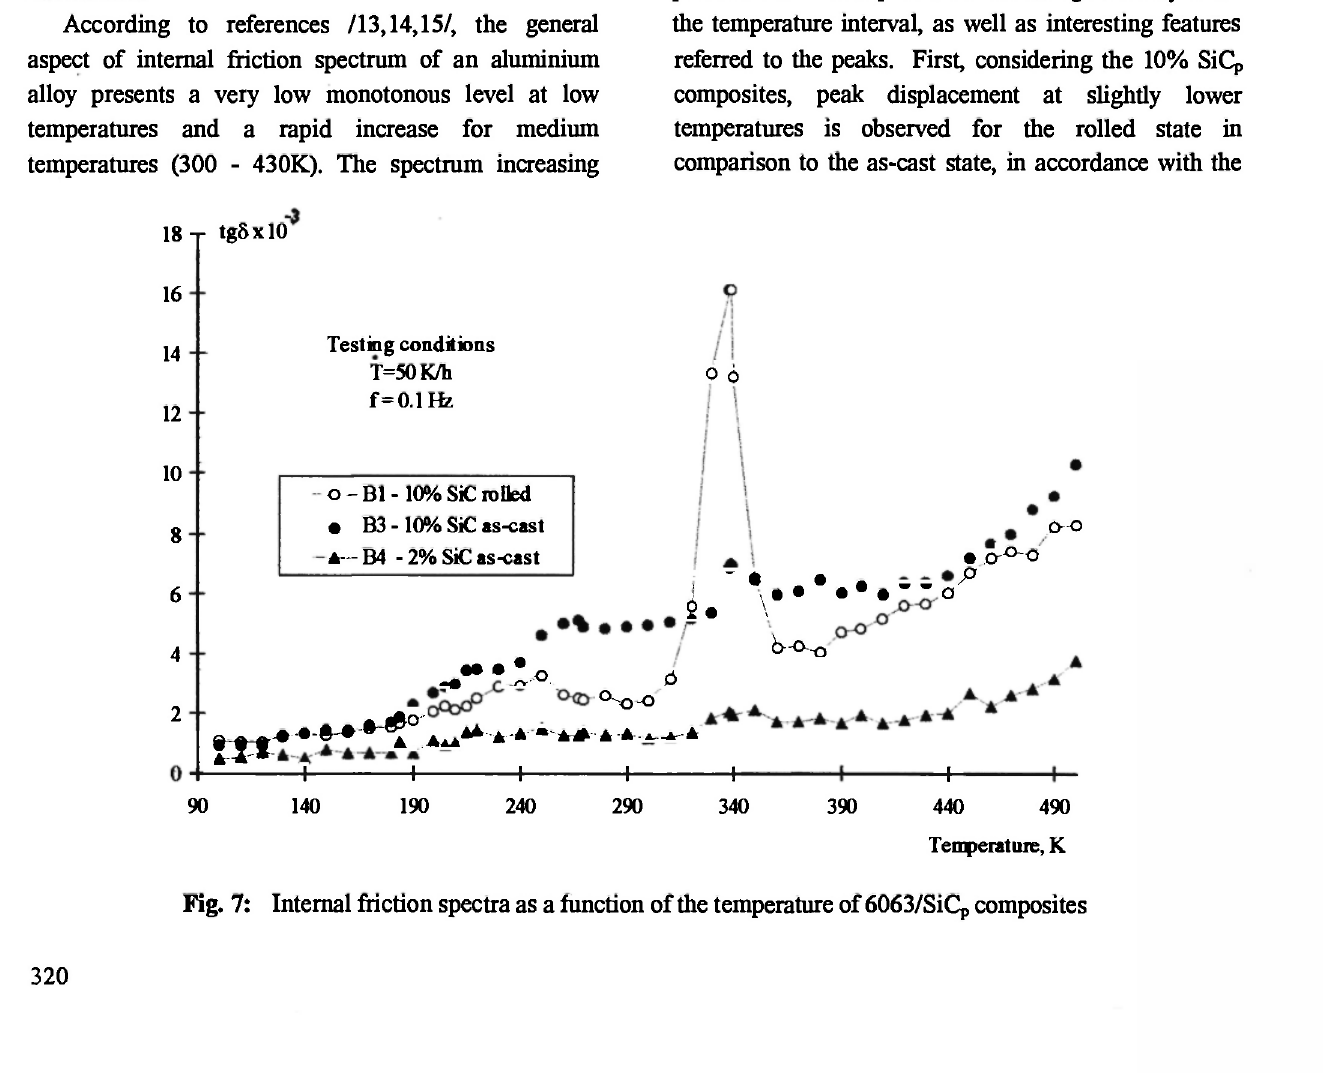
Fig. 7: Internal friction spectra as a function of the temperature of 6063/SiCp